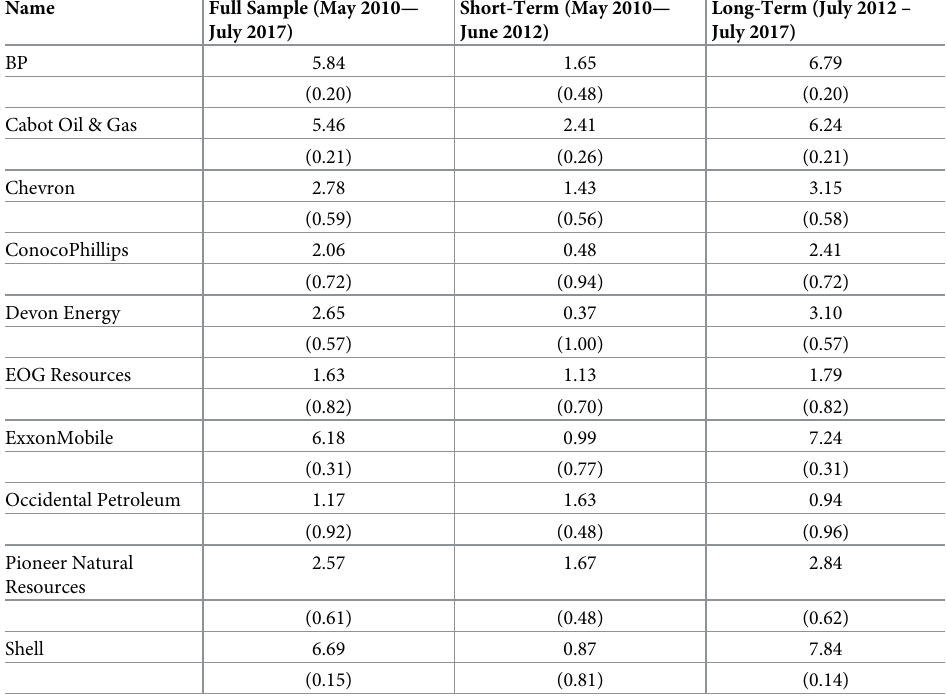
Table 5. Pre/post RMSPE ratios and P-values for oil & gas